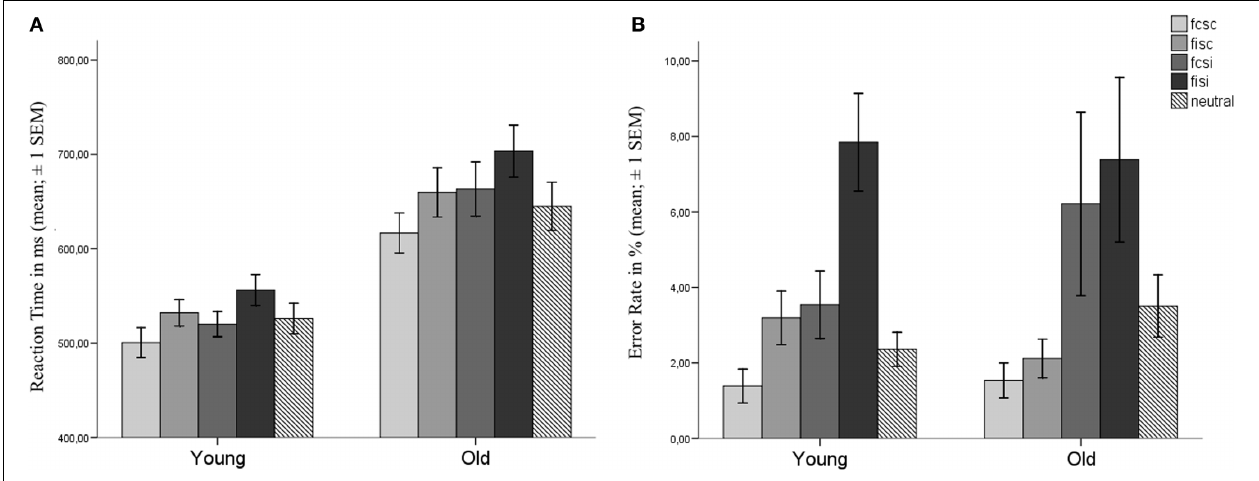
FIGURE 2 | Behavioral data. (A) reaction times and (B) error rates for young and old participants. Error bars show the standard error of the mean (SEM). Bars represent the different experimental conditions with congruent Flanker